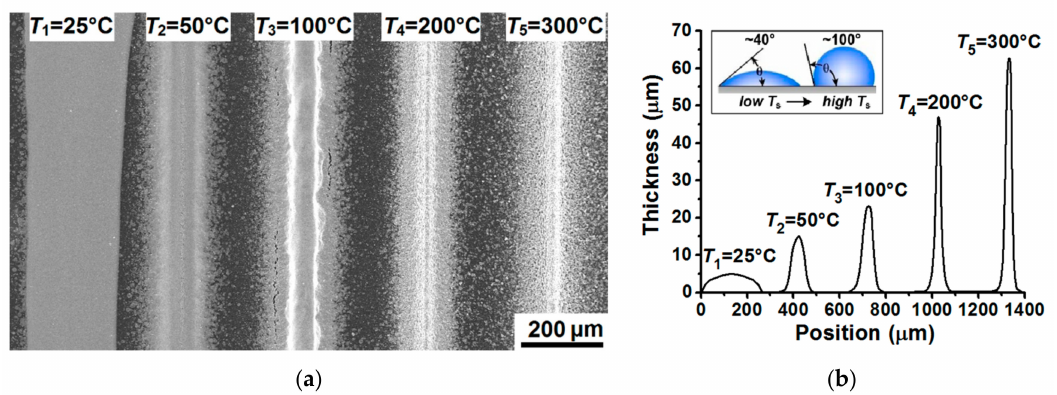
Figure 5. SEM image of lines formed by the method of aerosol jet printing on heated substrate, depending on the substrate temperature T s equal to 25 ◦ C, 50 ◦ C, 100 ◦ C, 200 ◦ C, and 300 ◦ C at N = 10 layers, V = 100 mm / min and FR = 2 ( a ); Relevant line cross-section profiles measured with s an optical profilometer ( b